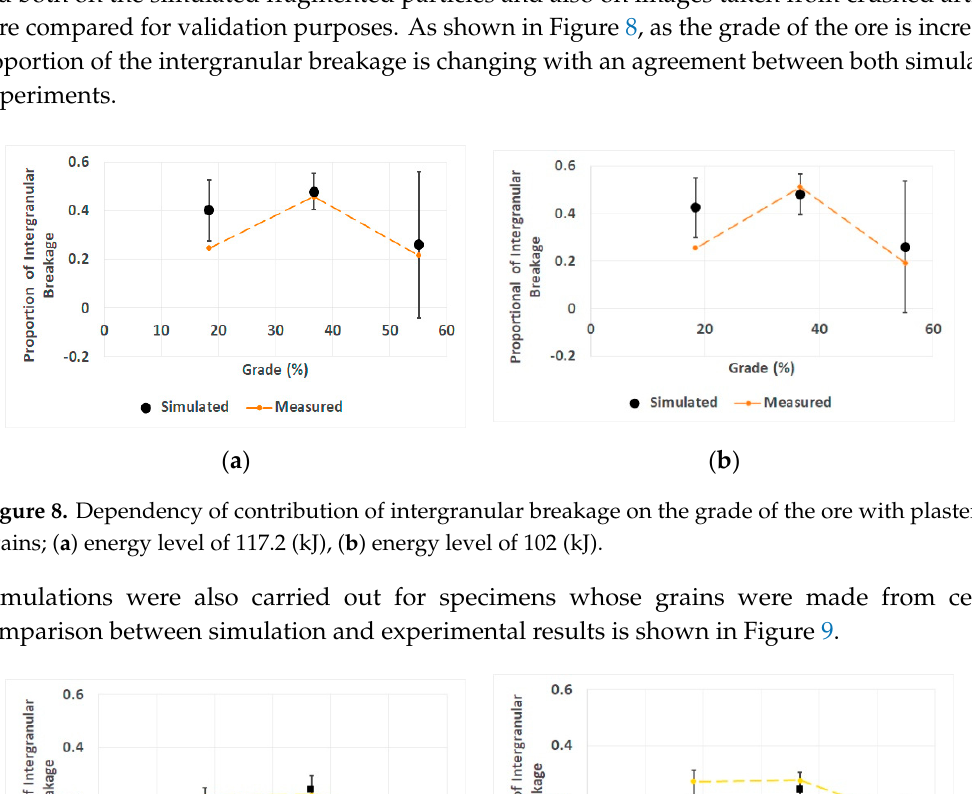
Figure 7. Preparing the crushed particles on a black background for taking images.